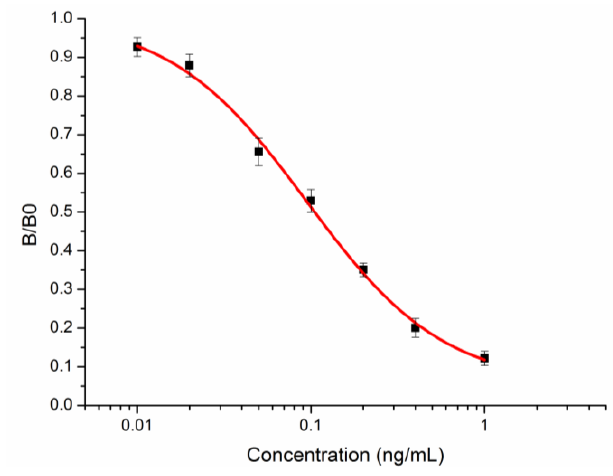
Figure 3. Standard inhibition curve of mAb 1F3 by